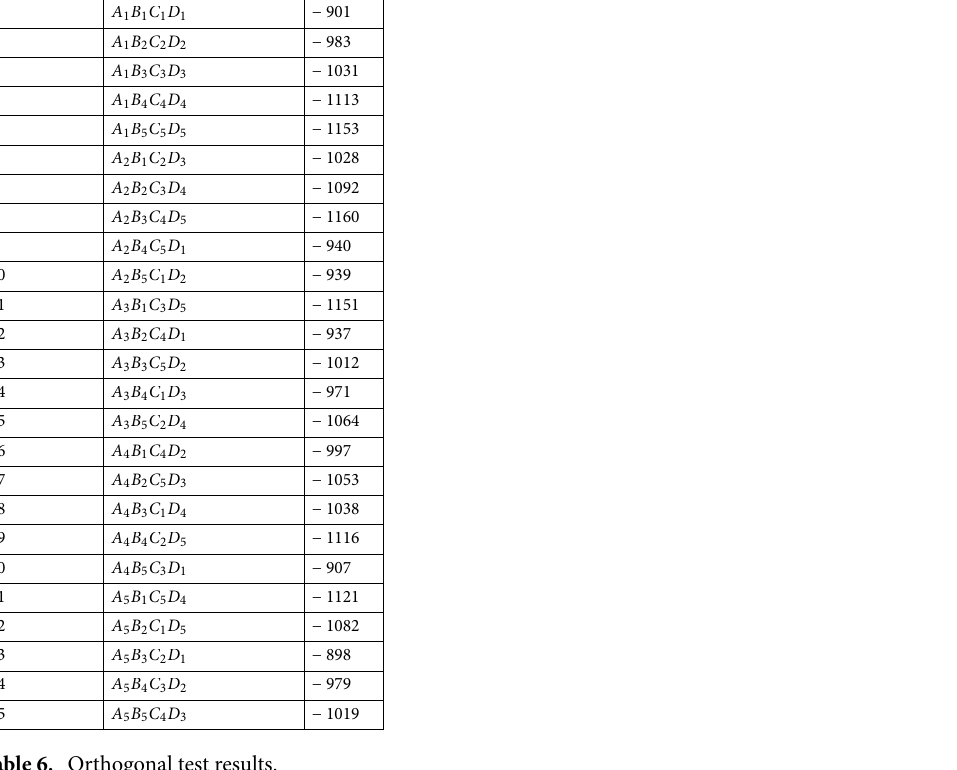
Table 6. Orthogonal test